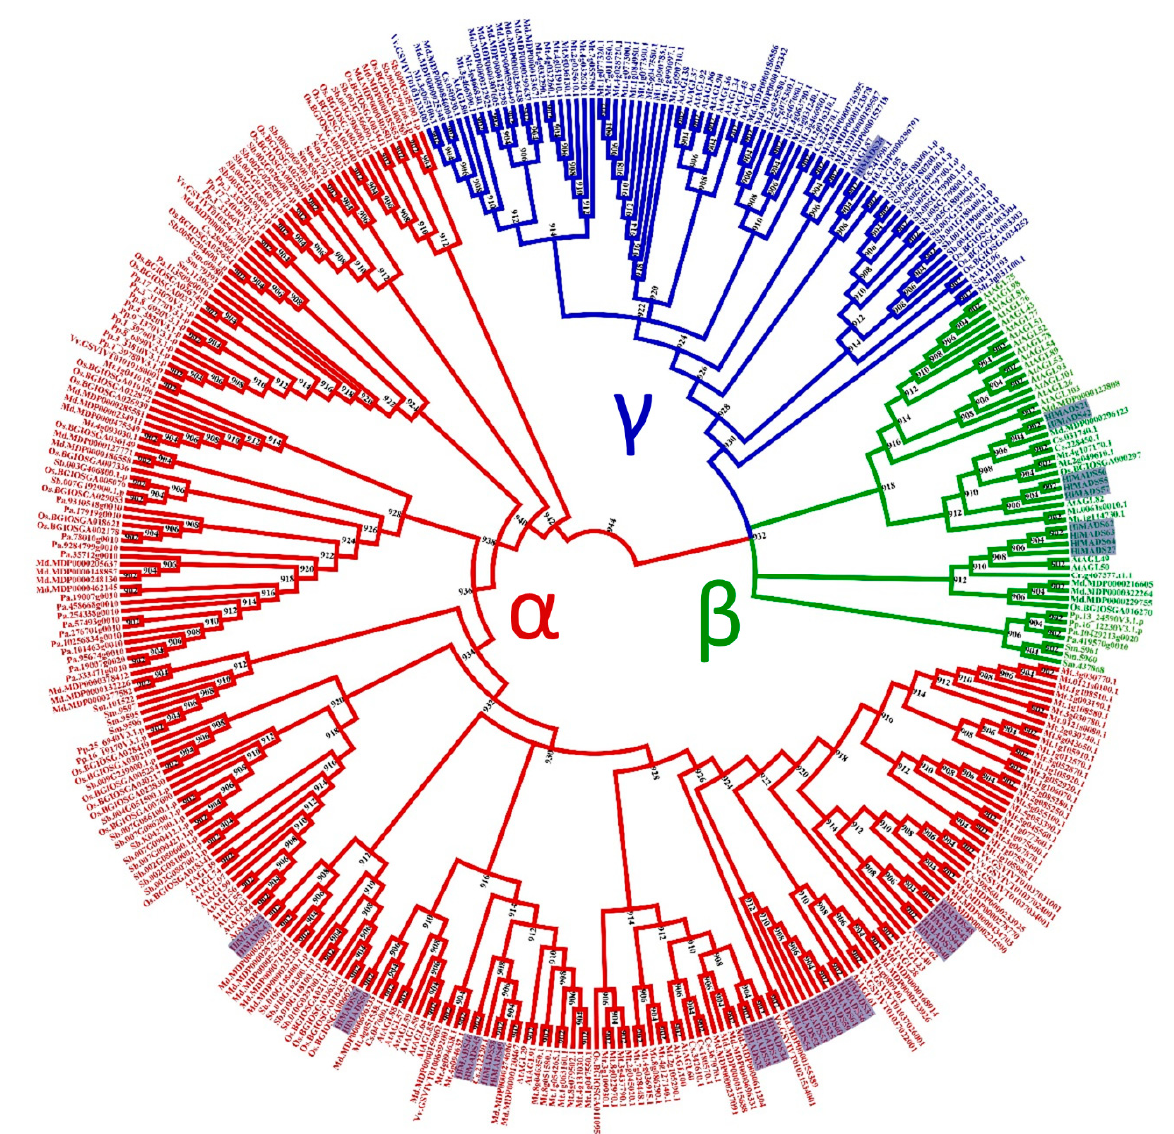
Figure 2. Phylogenetic tree of I-type MADS-box proteins of Humulus lupulus ((Hl) (36 sequences, highlighted)), Arabidopsis thaliana ((At) (58)), Chlamydomonas reinhardtii ((Cr) (1)), Physcomitrella patens ((Pp) (16)), Selaginella moellendorffii ((Sm)(14)), Piceaabies ((Pa) (18)), Sorghum bicolor ((Sb) (38)), Oryza sativa subsp. indica ((Os) (36)), Cucumis sativus ((Cs) (12)), Malus domestica ((Md) (56)), Medicago truncatula ((Mt) (79)), and Vitis vinifera ((Vv) (10)).